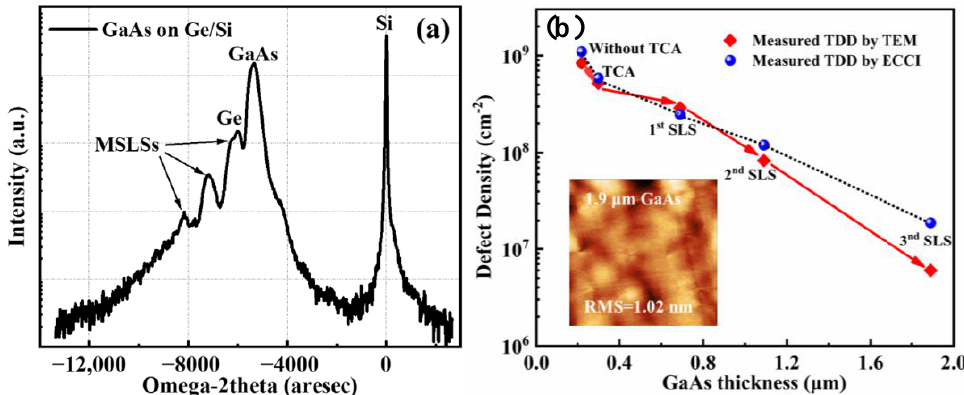
Figure 6. ( a ) HRXRD (004) RCs of GaAs layers on Ge-on-Si substrates with multi-SLS layers; ( b ) Extracted dislocation density as a function of the GaAs buffer thickness at various growth stages. The inset shows the 10 × 10 μm 2 AFM scan of the 1.9 μm GaAs buffer inserted with SLSs.